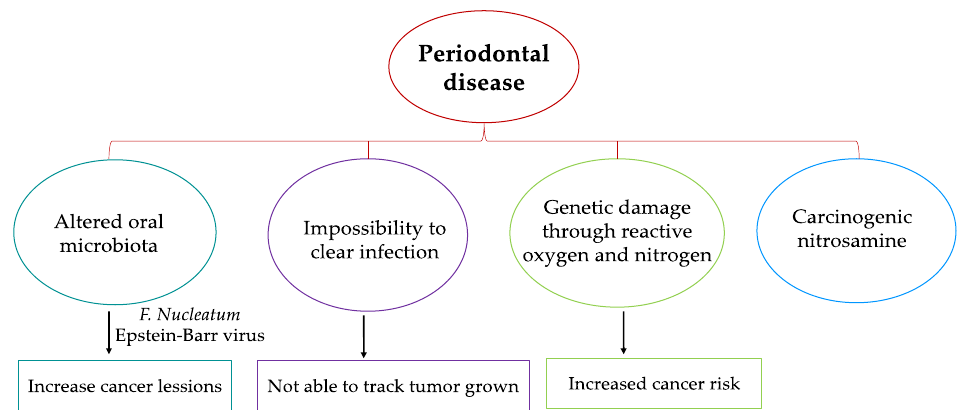
Figure 2. Schematic representation of potential processes involved in the periodontal disease–oral cancer connection.